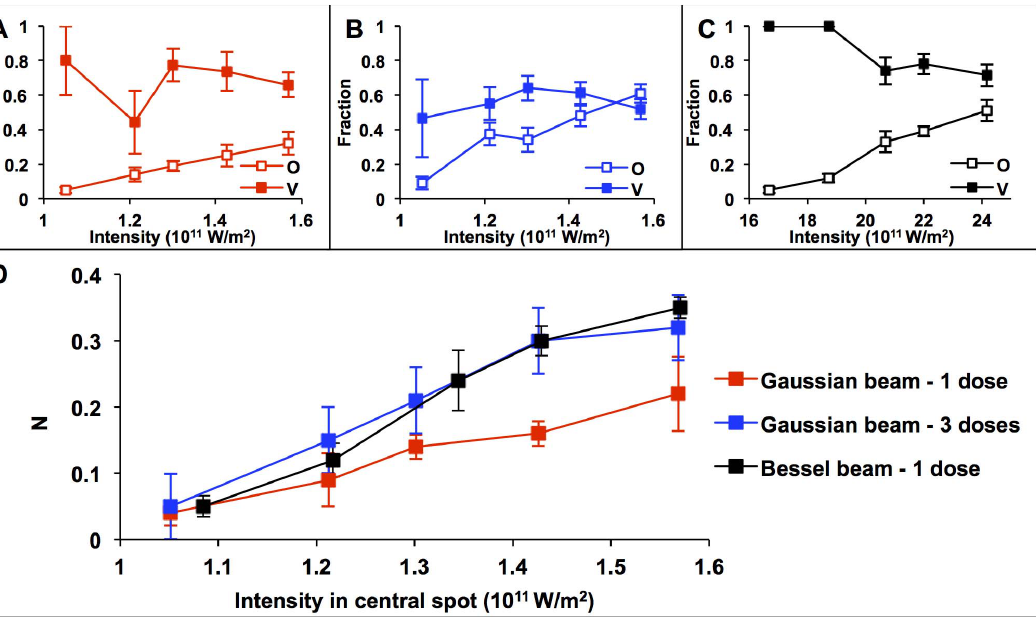
Figure 3. Optoinjection efficiency (O) and viability (V) of the BY-2 plant cells at different laser powers. After irradiation by (A) three shots or (B) a single shot with the Gaussian beam or (C) a single shot with the Bessel beam. For both beam geometries the optoinjection efficiency (represented by open squares) increases with power at the focal plane while viability (solid squares) usually decreases. C shows N (the proportion of cells being both viable and optoinjected) for varying central spot intensities. N increases as the intensity increases. The Bessel beam (black) shows a higher value for N than the Gaussian beam (red) when considering a single shot. When comparing with three axially separated shots of the Gaussian beam (blue), N is comparable to the Bessel beam. Each data point represents the mean for n=5 with 20 cells per experiment. Error bars represent the standard error of the mean (S.E.M.).